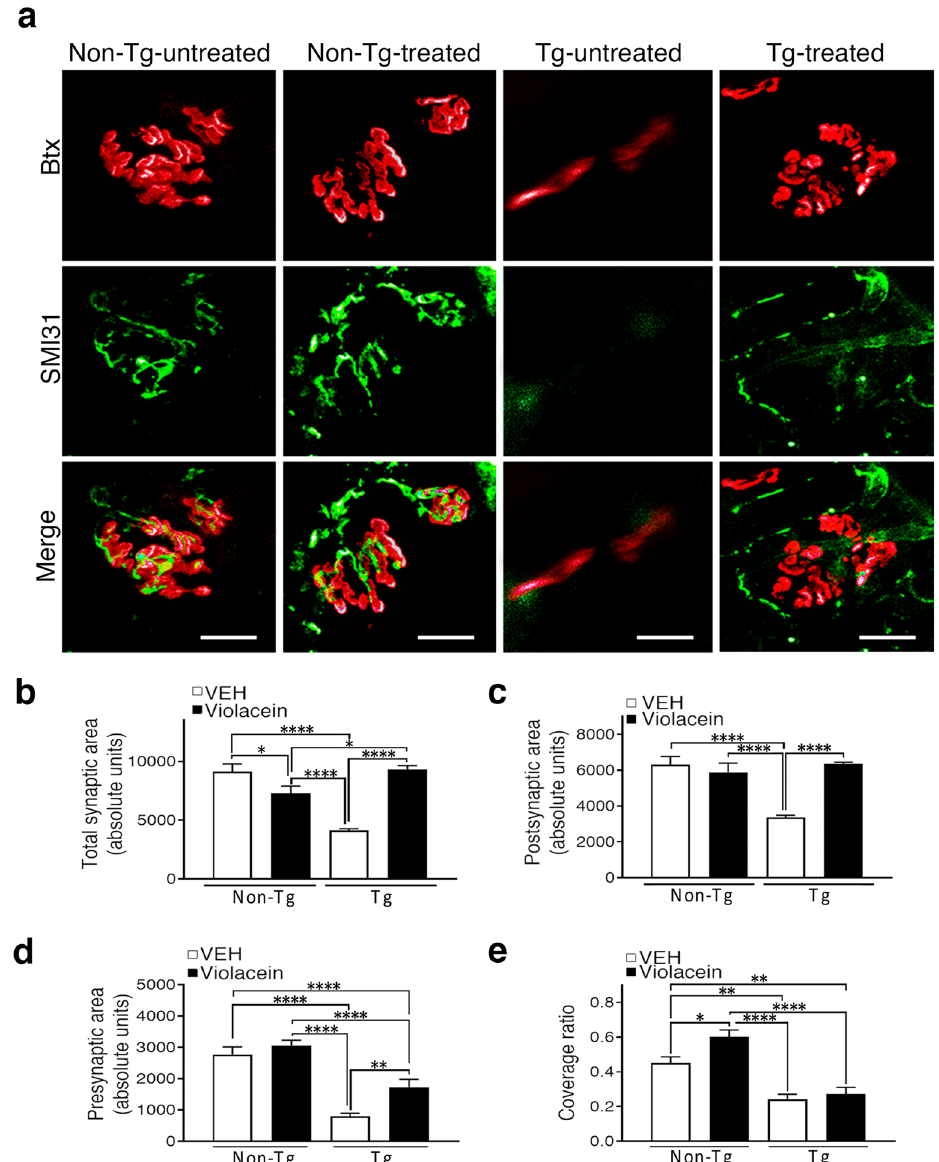
Figure 4. Violacein effects on soleus NMJs. ( a ) Representative confocal Z-stack images of NMJ immunofluorescences from each experimental condition. The alignment between the overlying nerve terminals labelled with SMI31 (green) and underlying acetylcholine receptors labelled with αBungarotoxin (Btx, red) is clearly shown in Non-Tg rats. The almost complete disappearance of both NMJ components is observed in Tg-untreated rats. Instead, Tg-treated showed a notable preservation of the postsynaptic element (pretzel shape) together with an improved signal of the presynaptic component. Calibration: 20 µm. ( b ) Quantitation of the total synaptic area showed decreases in Tg-untreated versus Non-Tg (p < 0.0001) or Tg-treated rats (p < 0.0001) and no differences between Tg-treated and Non-Tg rats (p > 0.9999). ( c ) Quantitation of Btx positive postsynaptic areas showed decreases in Tg-untreated related either to Non-Tg or to Tg-treated (p < 0.0001) rats, and similar values in Non-Tg versus Tg-treated samples (p > 0.9999). ( d ) Assessment of the phosphorylated NMJ presynaptic component indicated decreased values in Tg-untreated as well as in Tg-treated versus Non-Tg rats (p < 0.0001 for both comparisons). However, Tg-treated showed the half of the loss seen in Tg-untreated animals. Thus, violacein allowed that Tg-treated rats almost preserved a duplicated innervation area when compared with Tg-untreated animals (p = 0.0084). ( e ) Quantitative analysis of the coverage ratio indicated that violacein did not influence this parameter in Tg-treated versus Tg-untreated rats (p =